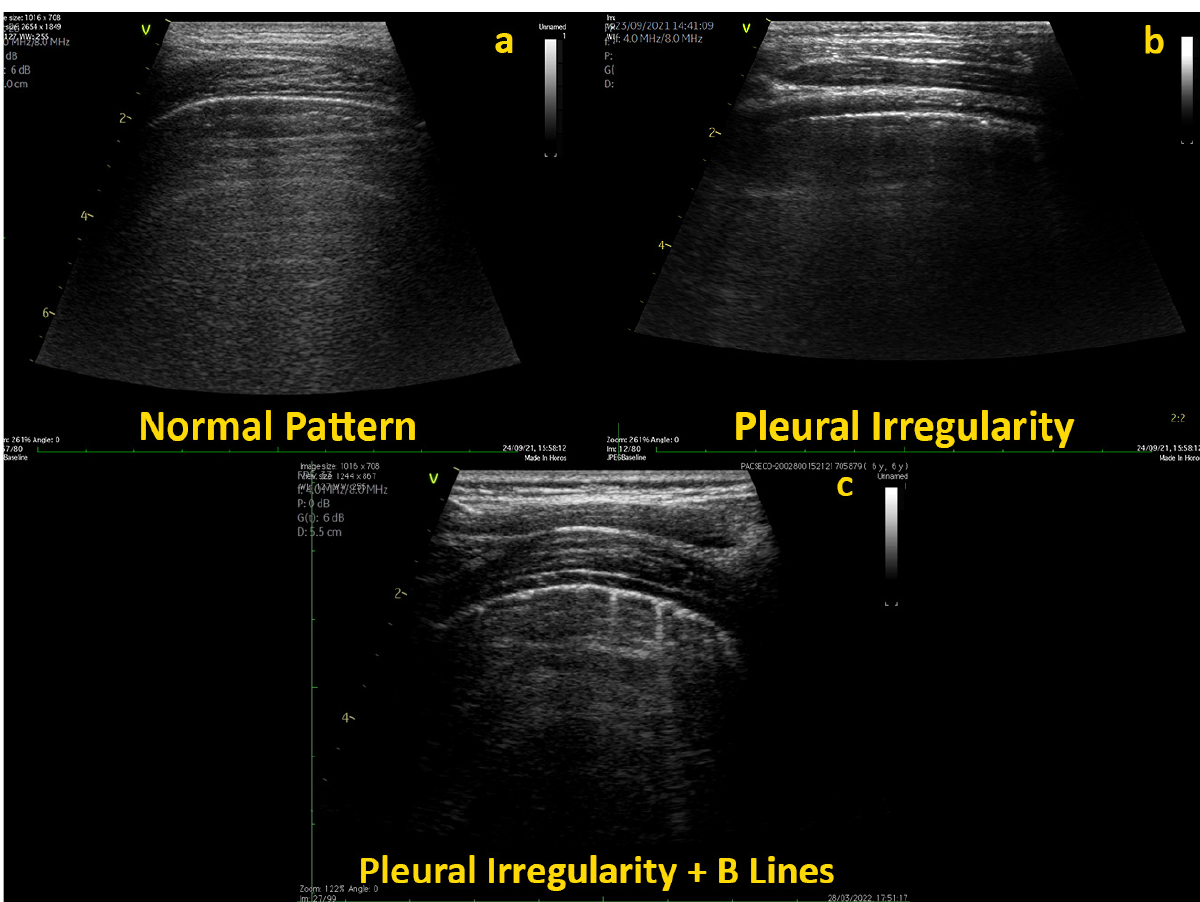
Figure 1. Normal LUS examination with: ( a ) no B-lines and no subpleural artifacts; ( b ) mild sub- pleural artifacts and no B-lines; and ( c ) mild subpleural artifacts and rare B-lines. Pattern 1: Absence of sub-pleural artifacts and no B-lines, point 0; Pattern 2: Only mild basal posterior sub-pleural artifacts and no B-lines, point 0–0.1’; Pattern 3: Mild posterior basal, para-spine, and apical short subpleural vertical artifacts and no B-lines, point 0.1–0.2; Pattern 4: Mild posterior basal, para-spine, and apical short subpleural vertical artifacts and rare B-lines (e.g., ≤ 2 in each segment), point 0.2–0.4; Pattern 5: Mild, diffuse short subpleural vertical artifacts and rare B-lines (e.g., ≤ 2 in each segment), point 0.4–0.6; Pattern 6: Mild, diffuse short subpleural vertical artifacts and limited B-lines (e.g., ≤ 4 in each segment), point